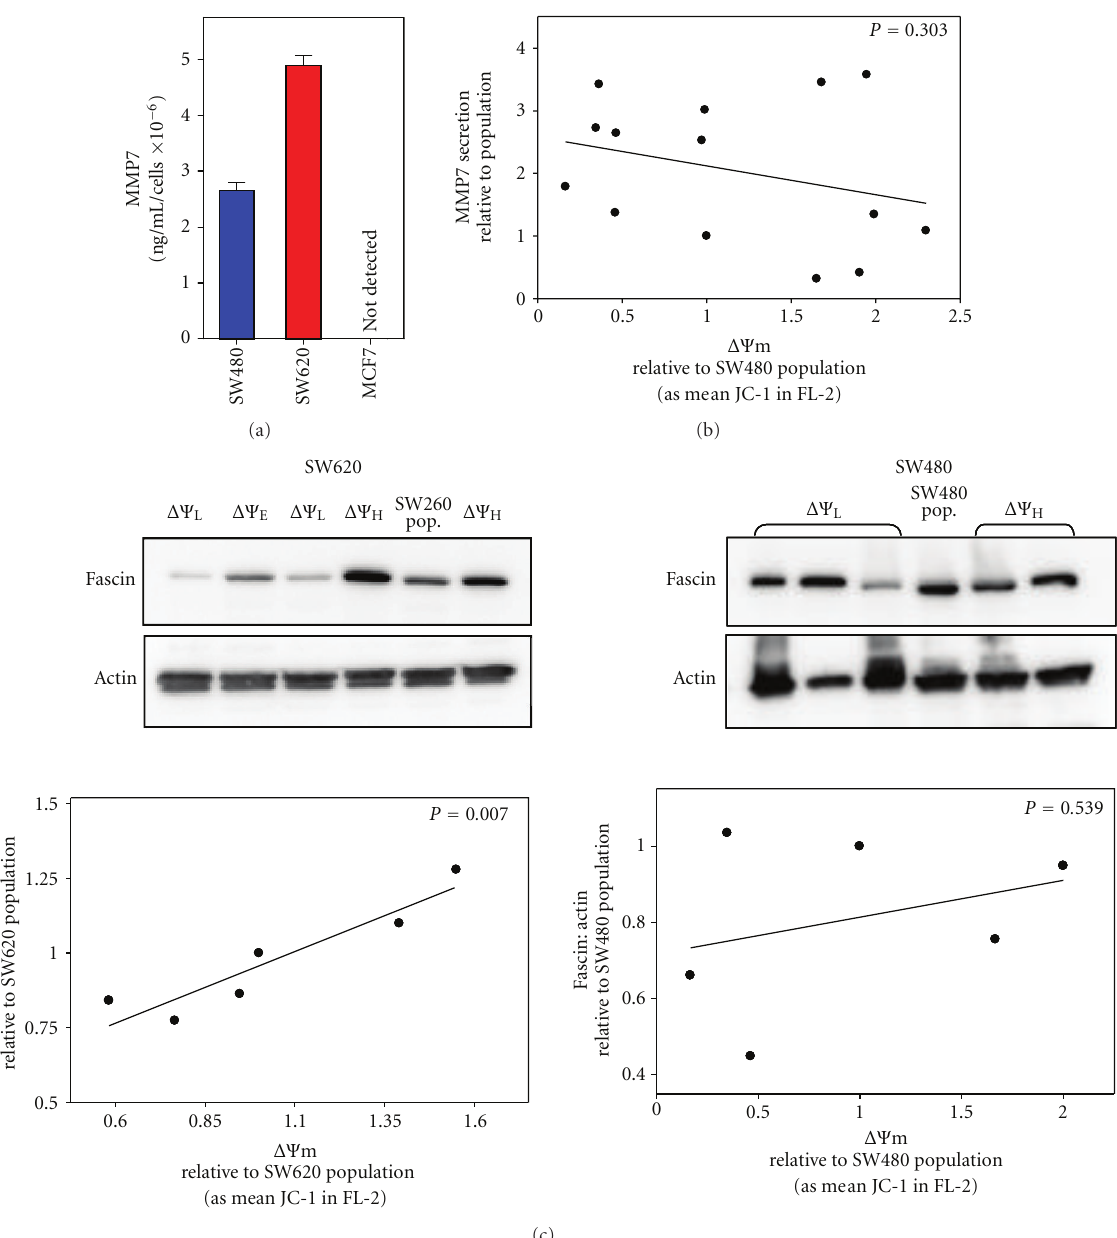
Figure 5: Di ff erences in the intrinsic ΔΨ m of subcloned cell lines derived from a metastatic colonic tumor, but not from the paired primary colon tumor , are linked to phenotypic markers associated with invasion. (a) and (b) MMP7 secretion levels were quantified by ELISA in condition medium harvest from SW480 and SW620 Cells (a) and from 13 subcloned cell lines derived from SW480 cells (b) and normalized for cells/well by the MTT assay. Secretion levels in parental SW480 and derived subclones are plotted as a function of relative ΔΨ m (b). (c) Fascin levels were determined in the SW480 and SW620 cell lines, and subclones derived from each of the cell lines, by immunoblotting normalized to actin. Reactions were quantified by densitometry and plotted as a function of relative ΔΨ